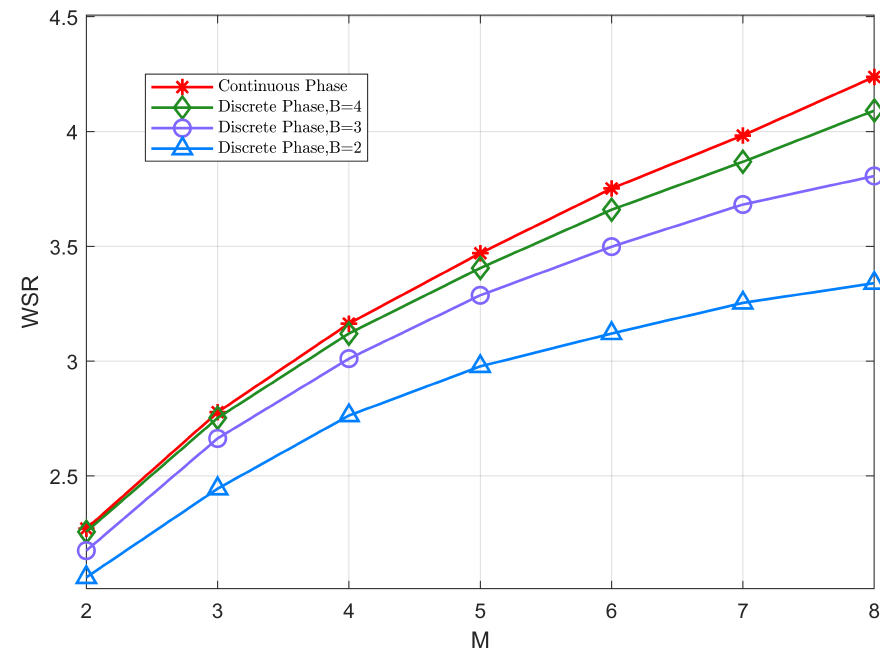
Figure 8. The WSR versus the number of transmit antennas M at the BS.